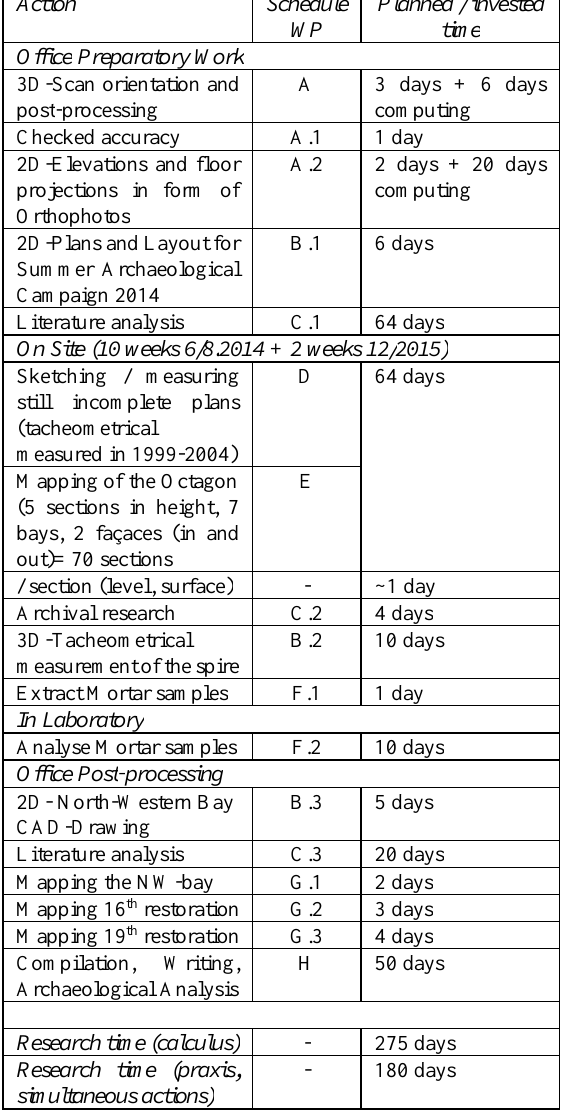
Table 1. Timeline of the research with work